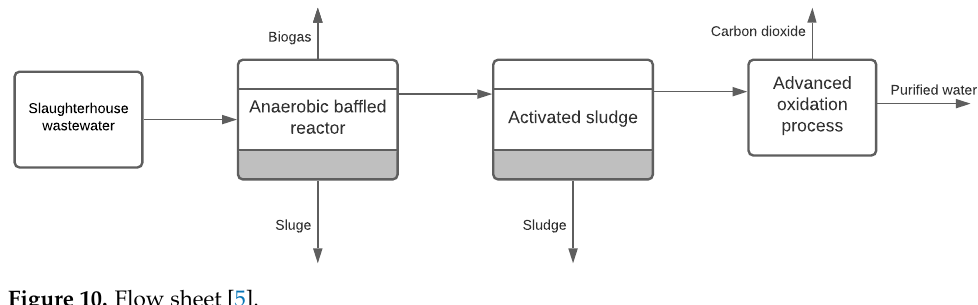
Figure 10. Flow sheet [5].